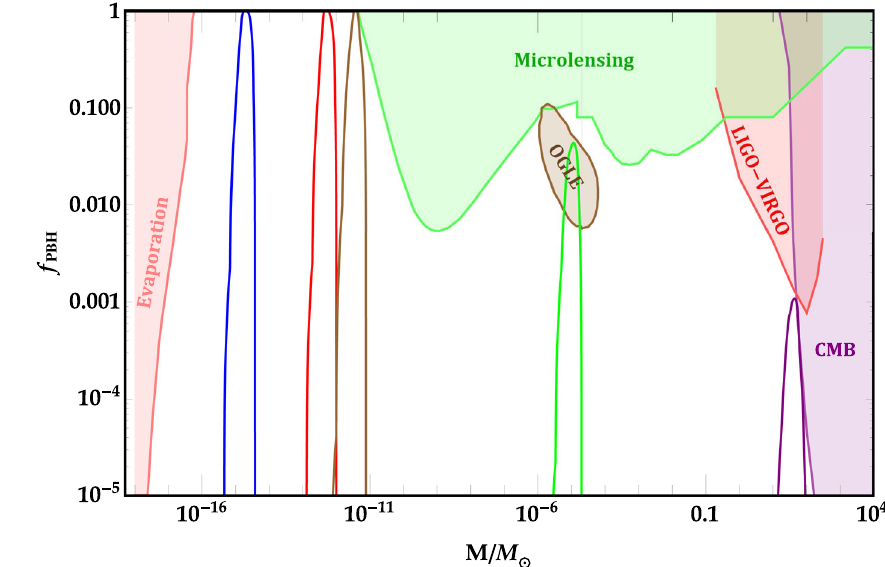
microlensing events in the OGLE data [16]. The green shaded area allots to constraints of microlensing events from cooperation between MACHO [104], EROS [105], Kepler [106], Icarus [107], OGLE [16], and Subaru-HSC [108]. The pink shadowy region delineates the con- straints related to PBHs evaporation such as extragalactic γ -ray back- ground [109], galactic center 511 keV γ -ray line (INTEGRAL) [23], and effects on CMB spectrum